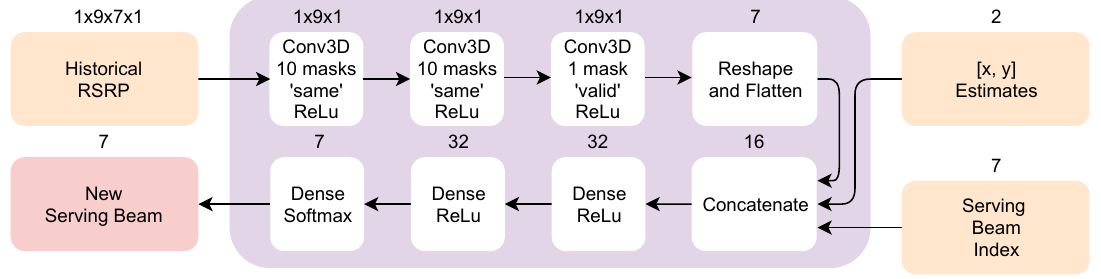
Figure 5. Proposed cell-level mobility model